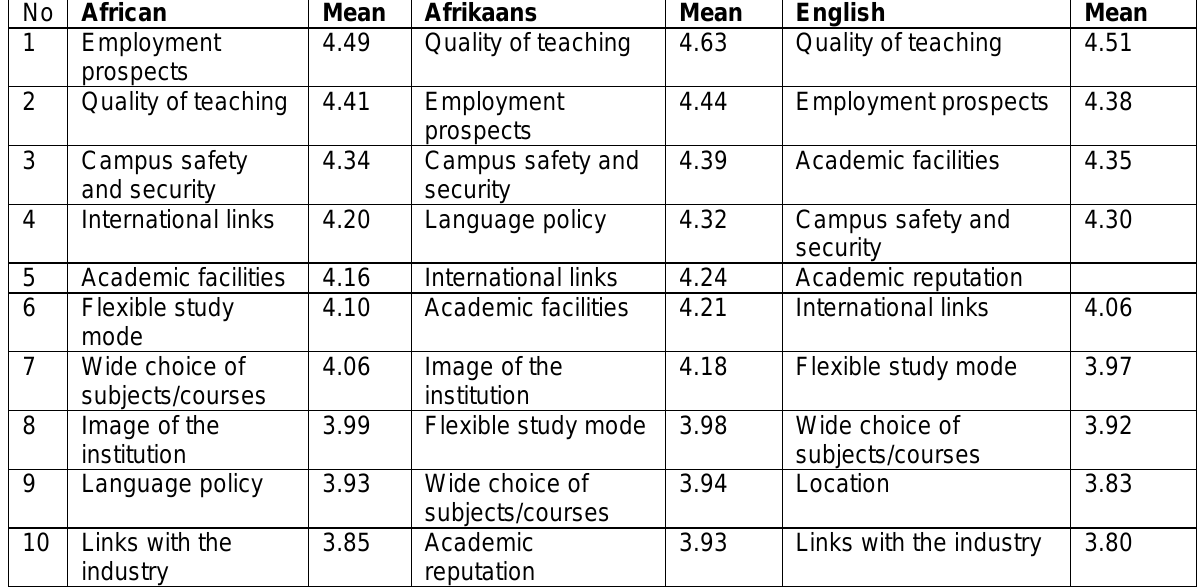
Table 3: Top ten choice factors per language group